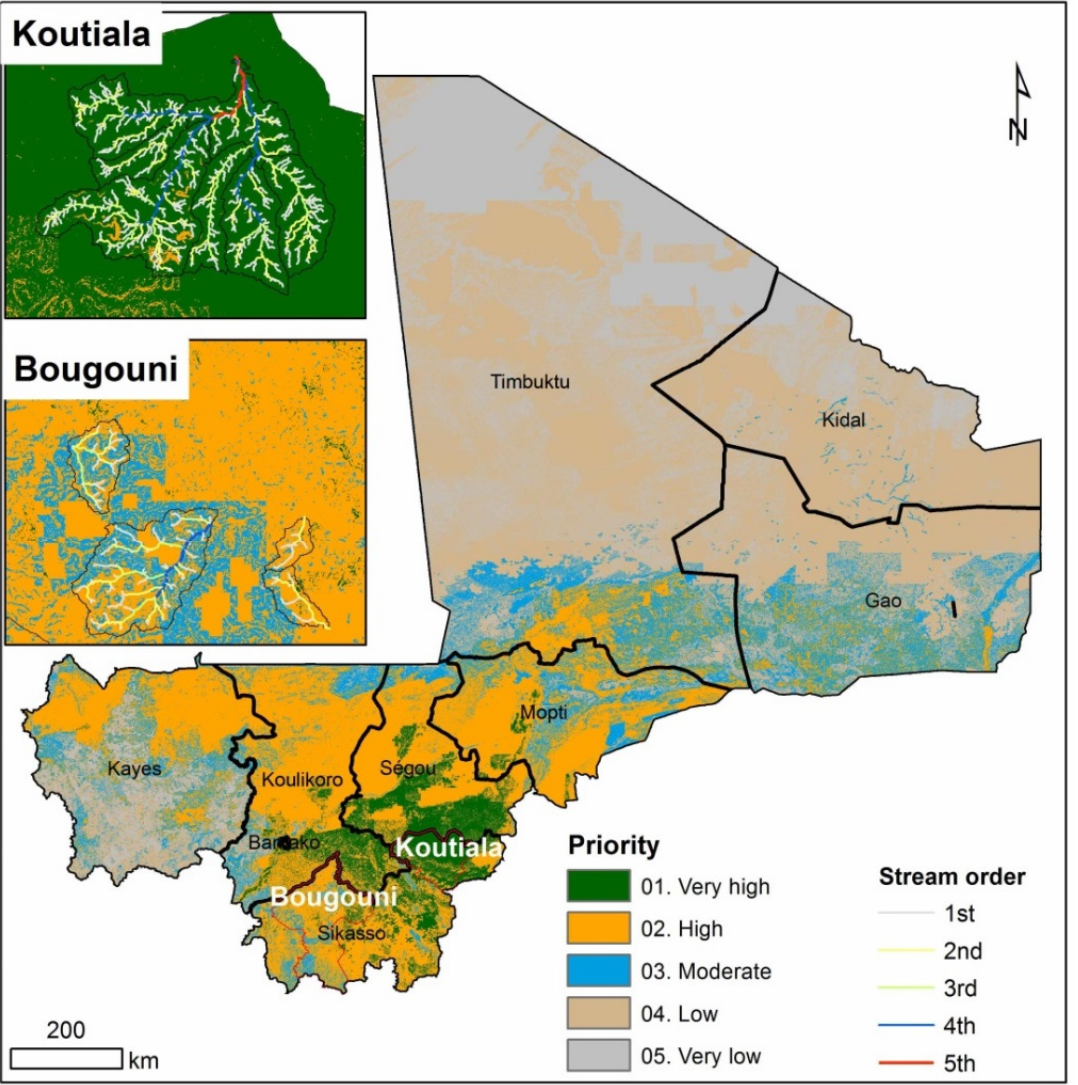
Figure 9. Priority zones for watershed based development across Mali. Test sites selected before this study (inset).